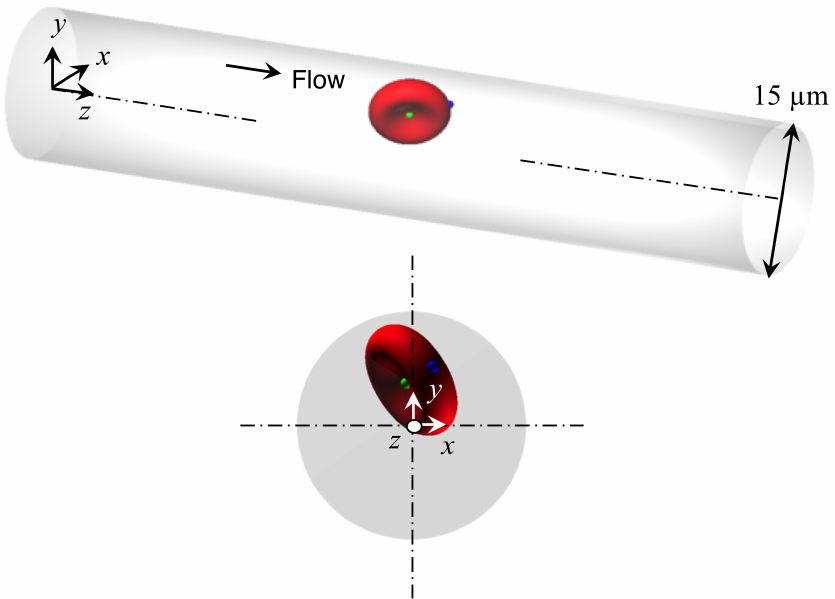
are represented by green dots, and those at the initial edge node point are indicated by blue dots.